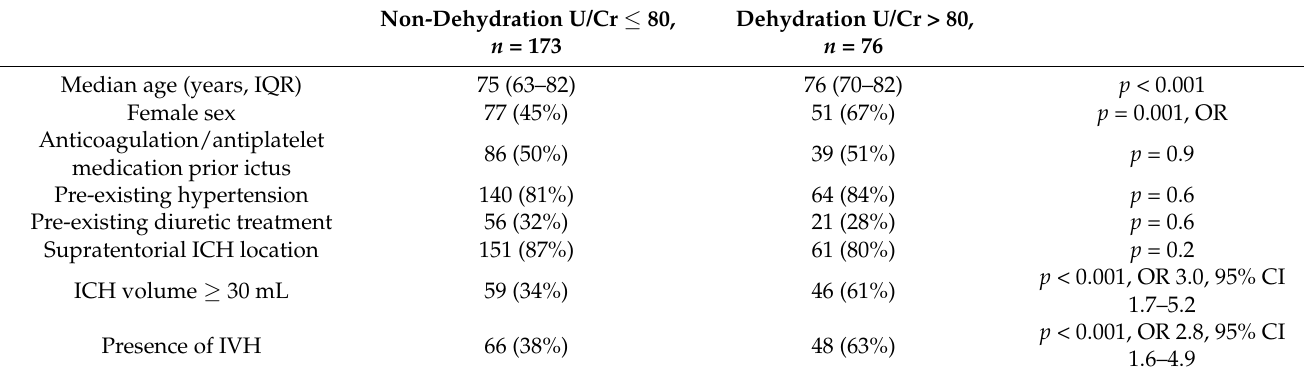
Table 2. Patient characteristics in non-dehydrated and dehydrated group with